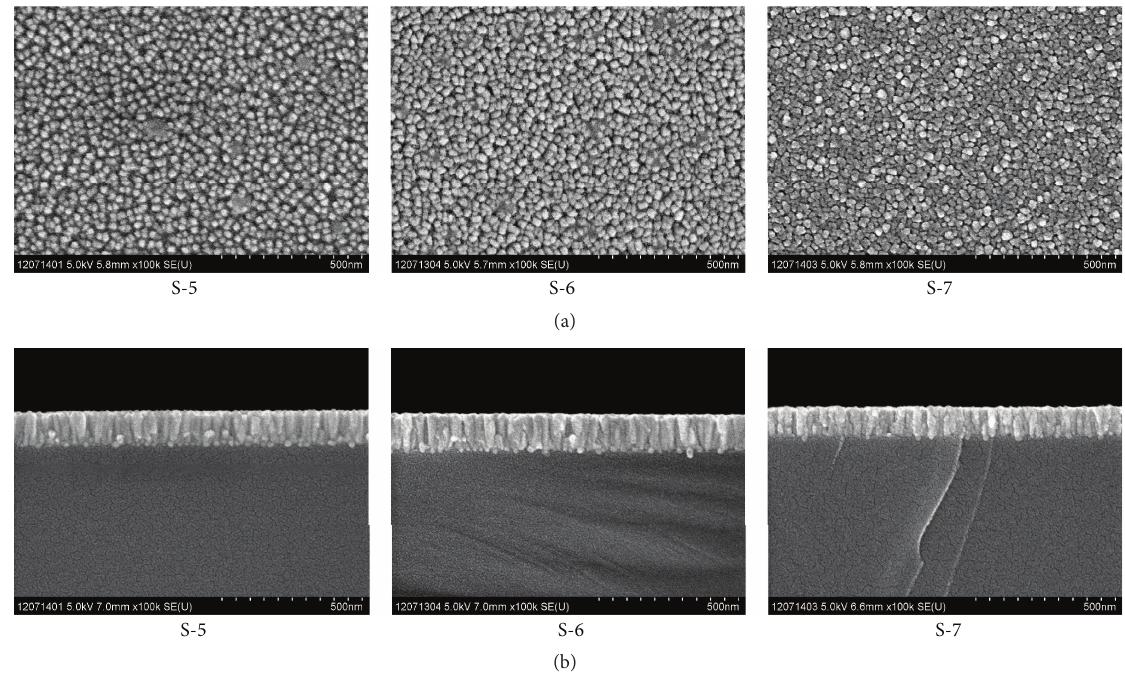
Figure 4: SEM images of the surface of the Al-doped CdO thin films: (a) S-5, S-6, and S-7 groups and cross-sectional SEM images; (b) S-5, S-6, and S-7